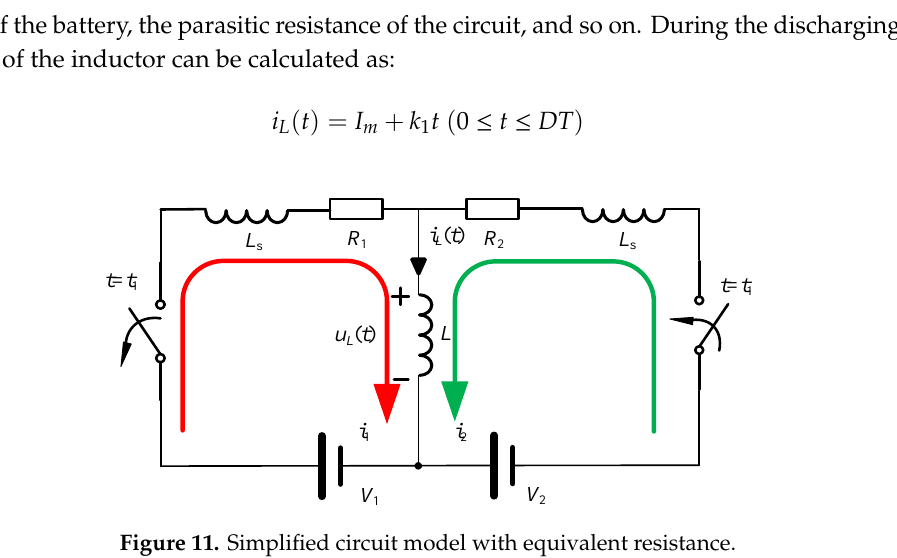
Figure 11. Simplified circuit model with equivalent resistance.